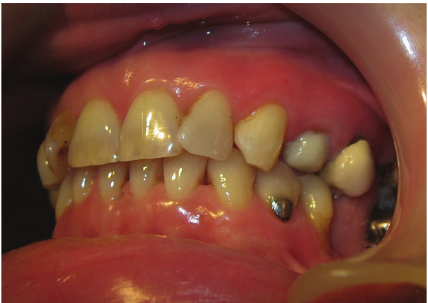
Figure 6: Resin core built on the titanium post before crown prepa- ration.